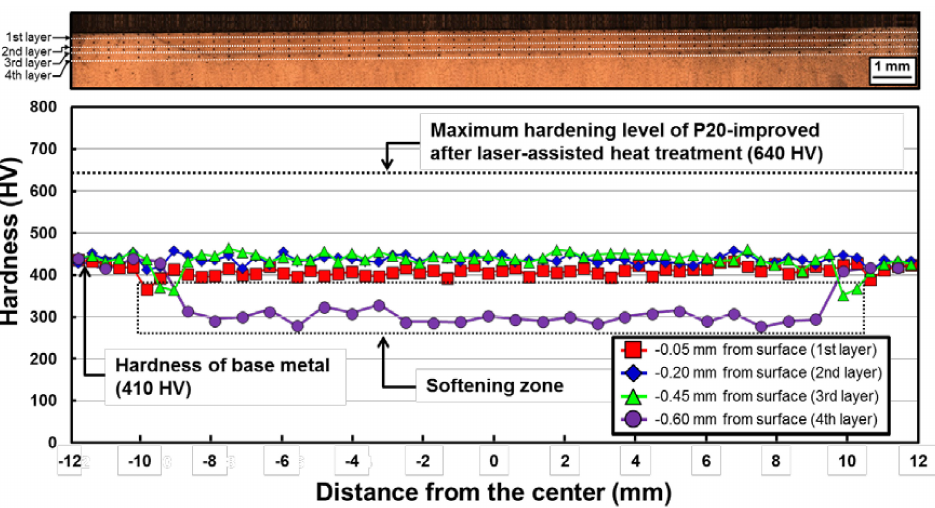
Figure 9. Hardness distribution and corresponding macrostructure of the heat-treated cross-sectional specimen at a temperature of 1473 K for P21